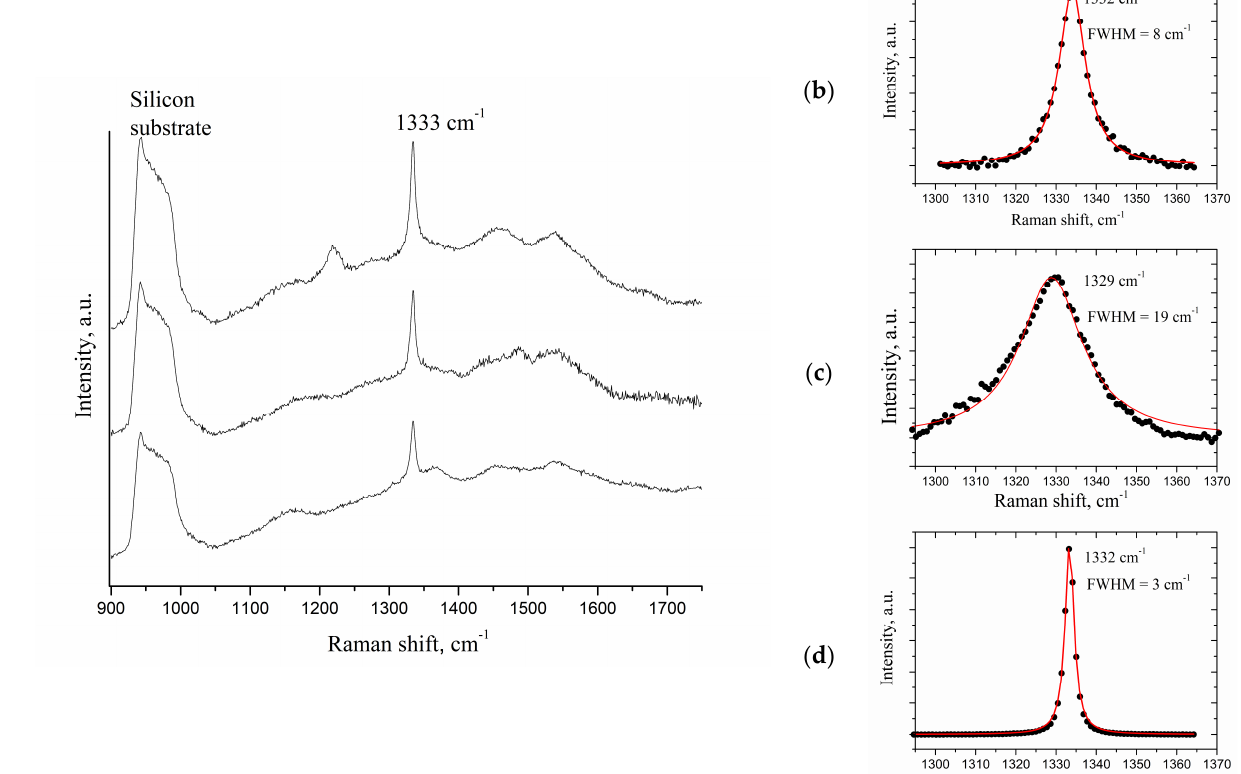
Figure 4. Raman spectra of various points of the CVD DND (Eu) film in different regions of CVD film ( a ). It is shown for comparison the diamond lines (1332 cm −1 ) for CVD DND (Eu) film ( b ), DND powder ( c ) and microsized diamond particles ( d ) measured using the same experimental set-up on a very large scale.